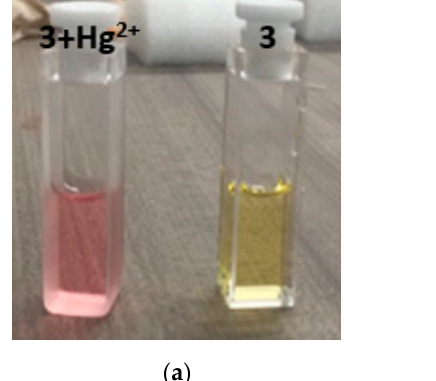
Figure 7. ( a ) Colorimetric change of compound 3 in the presence of mercuric ions; ( b ) fluorimetric change of compound 3 in the presence of mercuric ions.